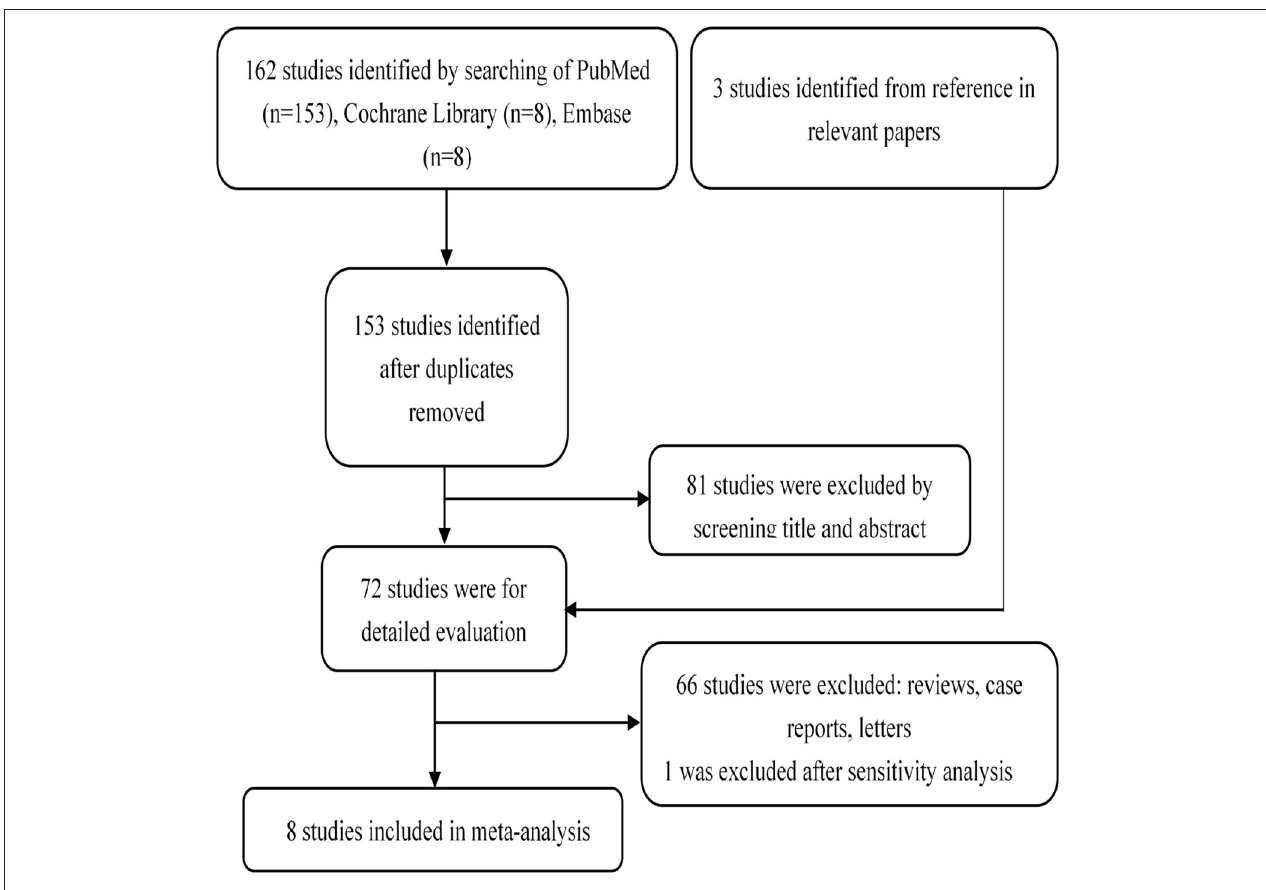
FIGURE 1 | Flow chart demonstrating process of study selection.